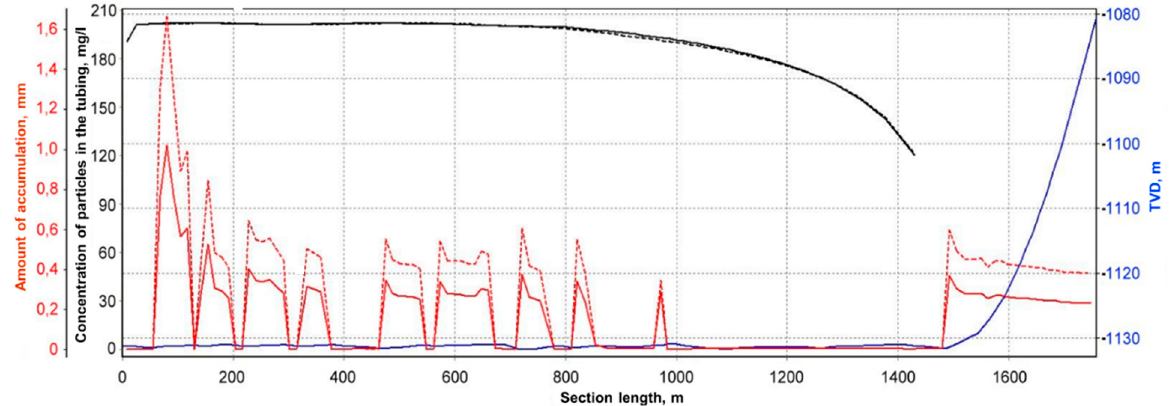
Figure 3. Stationary recovery of particles with diameter of 0.03 mm at rate of 200 m 3 /d: well geometry from toe to pump inlet (blue line), particle concentration in the flow in tubing (black lines), and accumulation of “pillow” from particles (red lines) at different moments in time: solid lines—12 h; dashed lines—24 h.